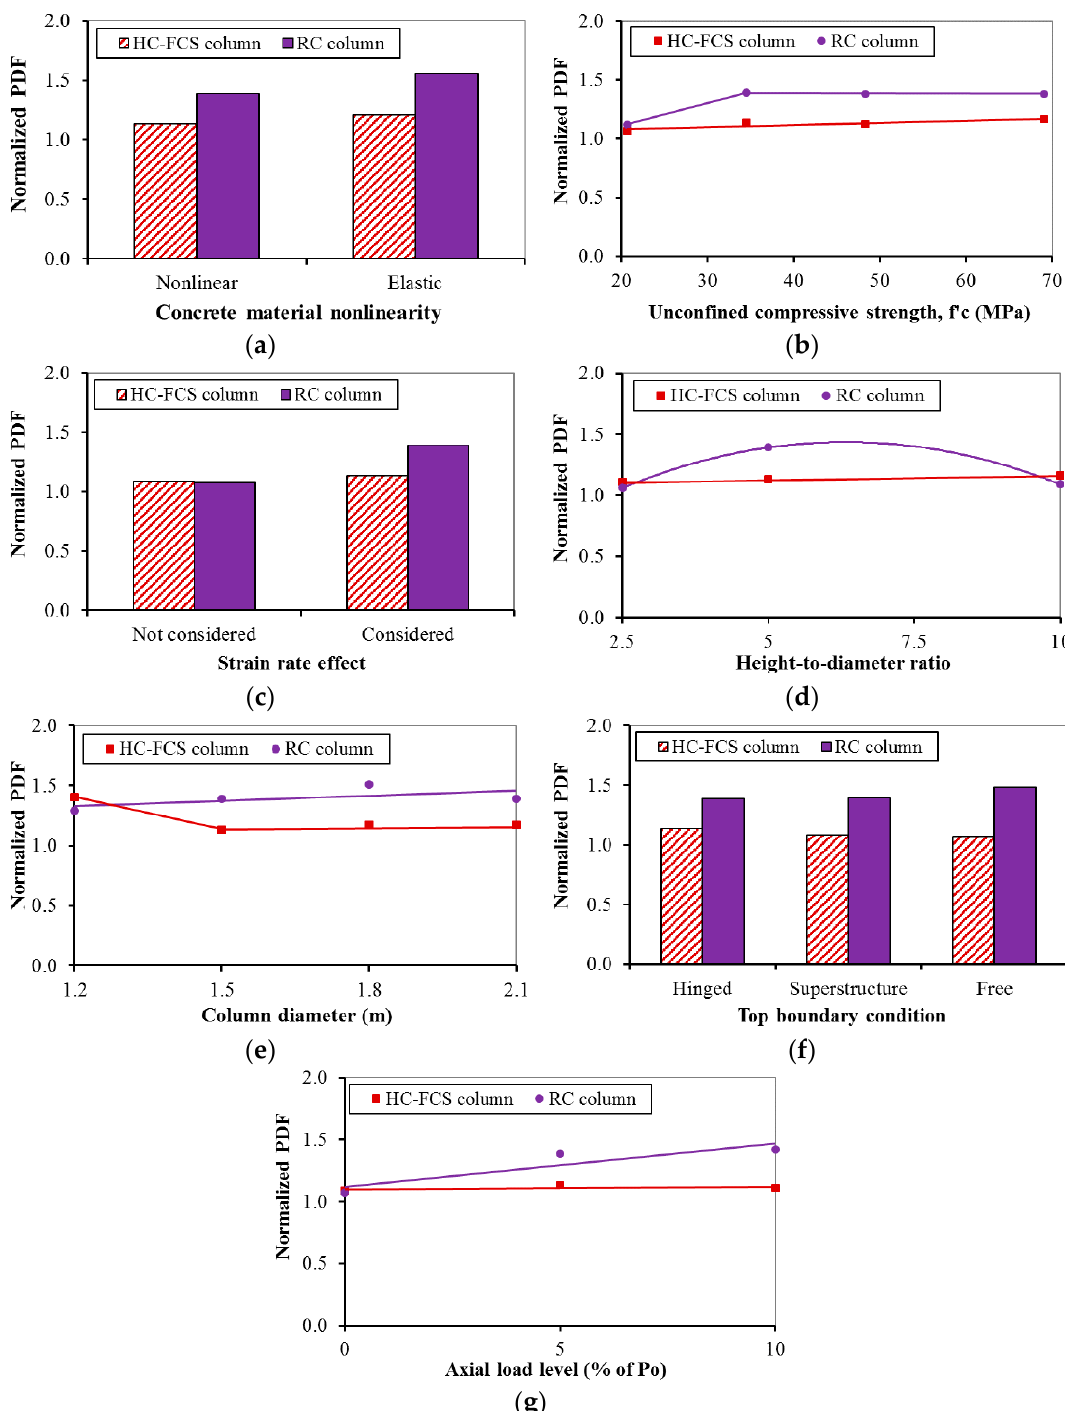
Figure 6. Effects of: ( a ) concrete material model; ( b ) concrete strength ( (cid:1858) (cid:3030)(cid:4593) ); ( c ) strain rate; ( d ) height-to-diameter ratio; ( e ) column diameter; ( f ) top boundary condition; and ( g ) axial load level on the PDF of the HC-FCS and RC columns.